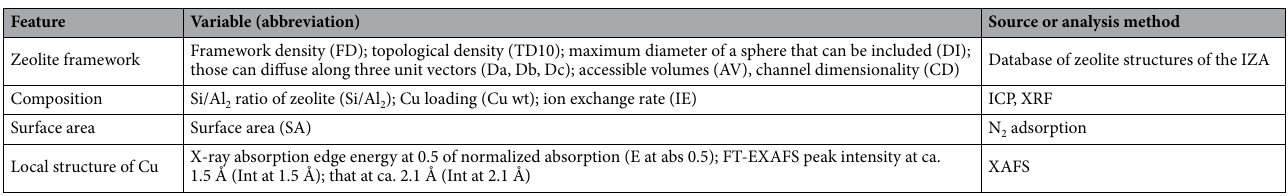
Table 1. Structural data collected as catalyst